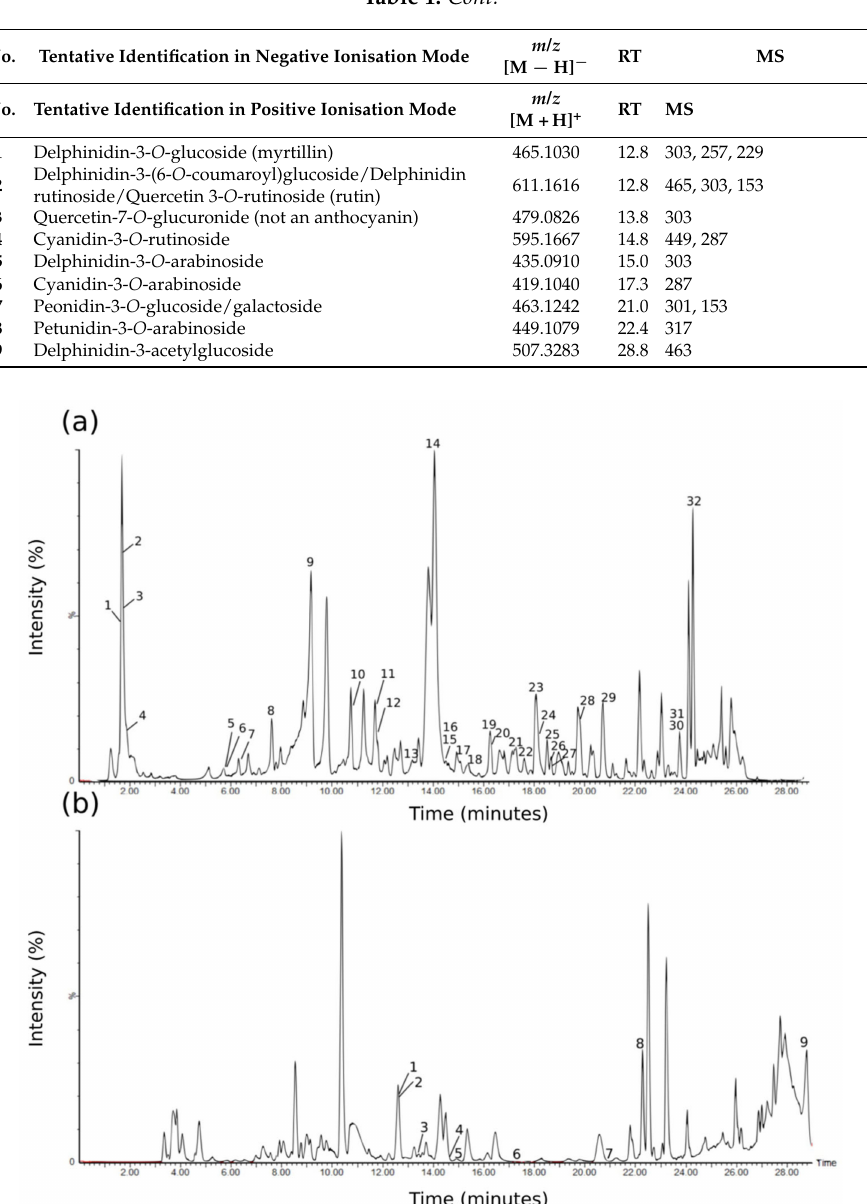
Figure 3. ( a ) Base peak intensity (BPI) chromatogram of the negative ionisation analysis. ( b ) BPI chromatogram of the positive ionisation analysis. The chromatograms are a representative sample from a locality in Namibia